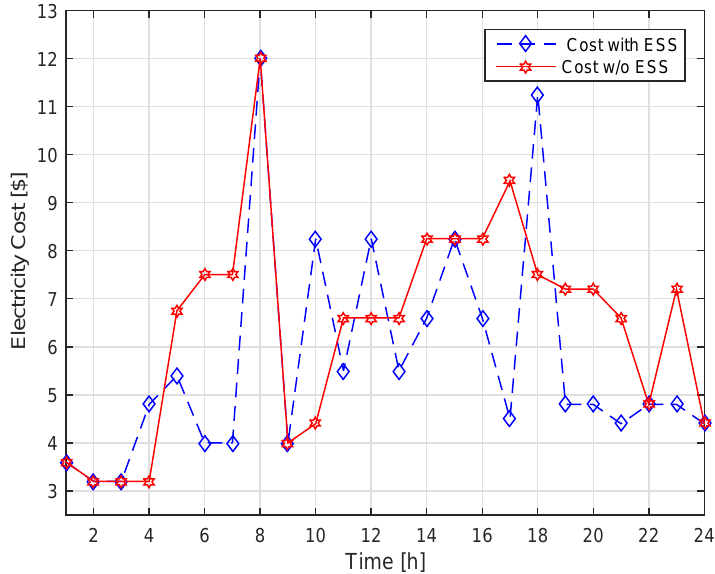
Figure 9. Aggregated cost with and without ESS of user1 and user2